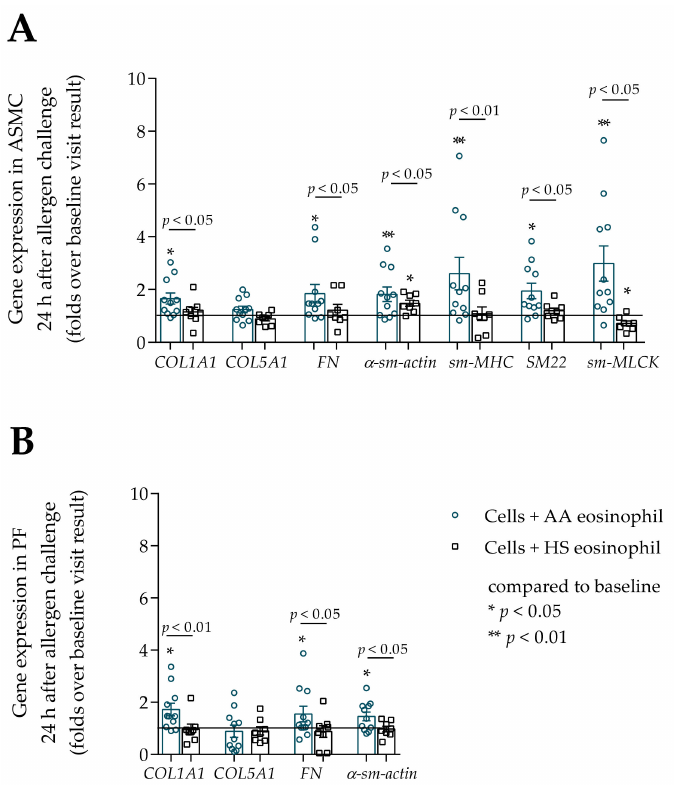
Figure 10. ( A )–The change in gene expression in ASMC 24 h after bronchial allergen challenge with D. pteronyssinus , ( B )–The change in gene expression in PF cells 24 h after bronchial allergen chal- lenge with D. pteronyssinus . Data presented as folds over baseline visit result as mean ± SEM. Added blood serum of each investigated subject to individual combined cultures: 2% v / v